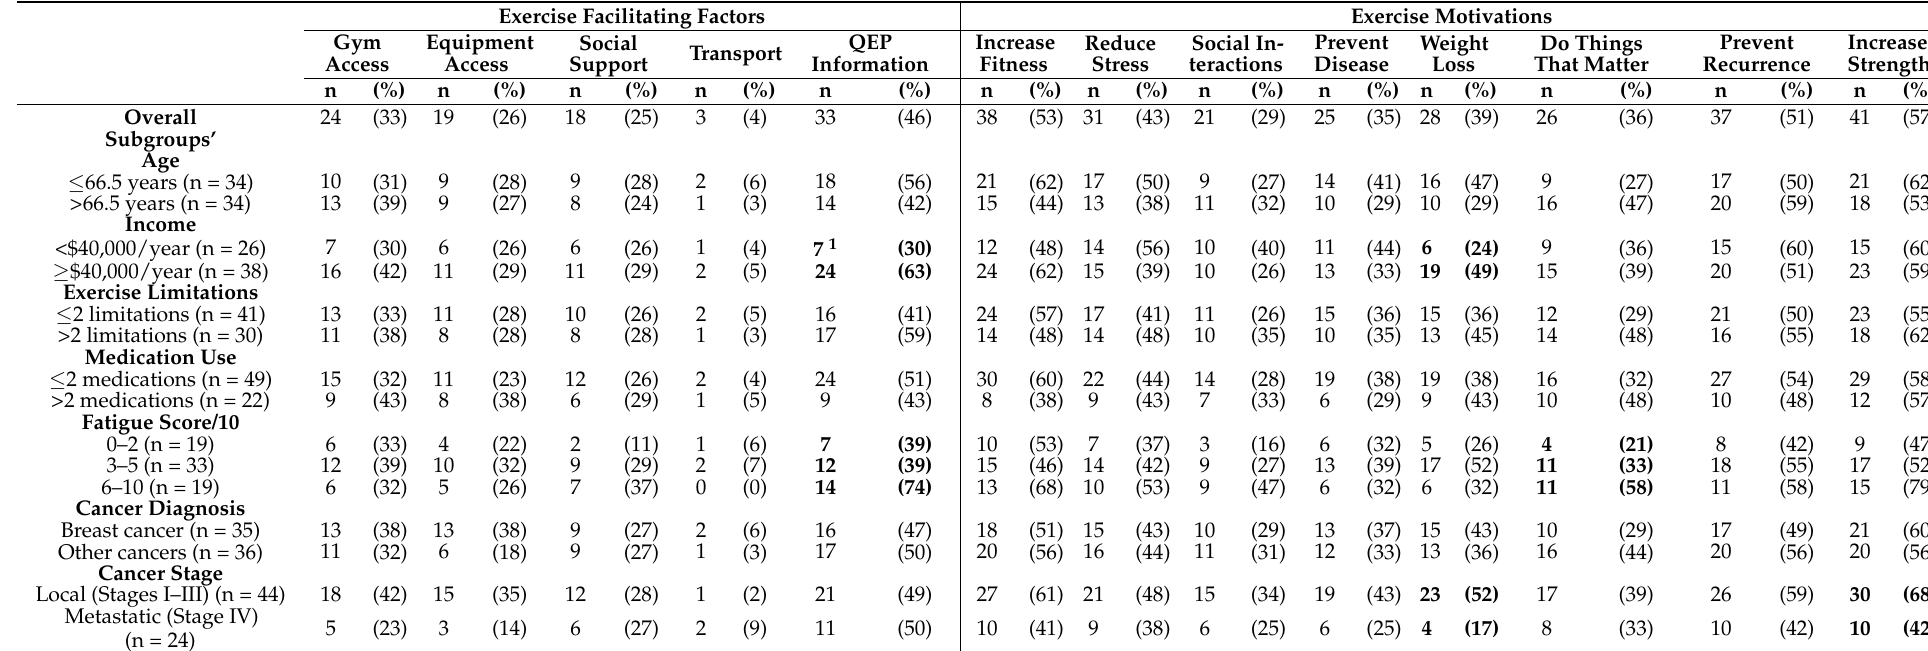
Table 5. Exercise-facilitating and -motivating factors for rural cancer